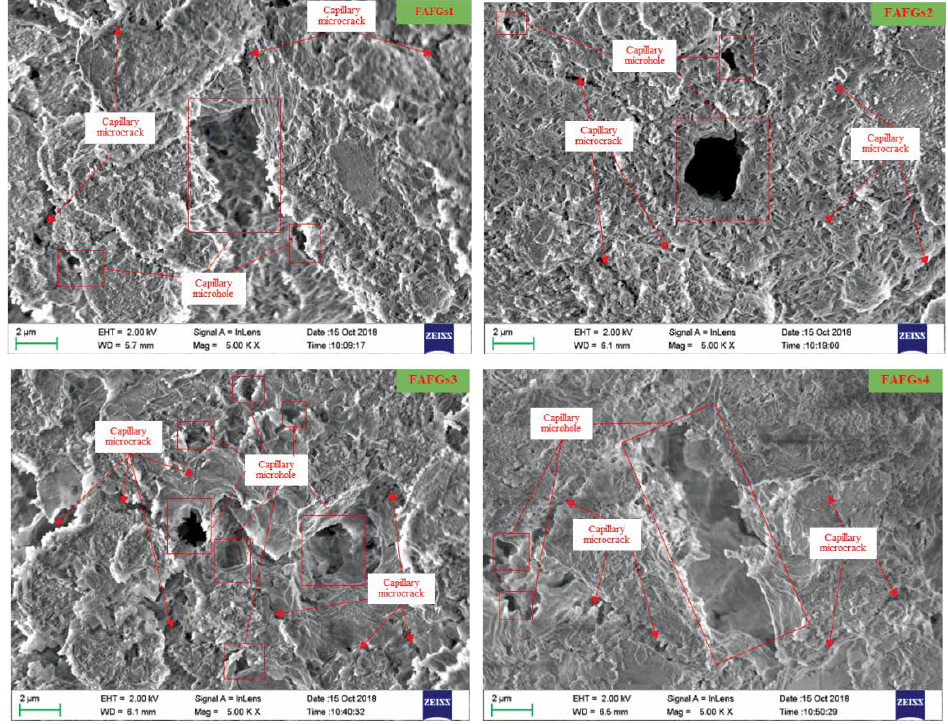
Figure 9: SEM result for micro-cracks & micro-holes of